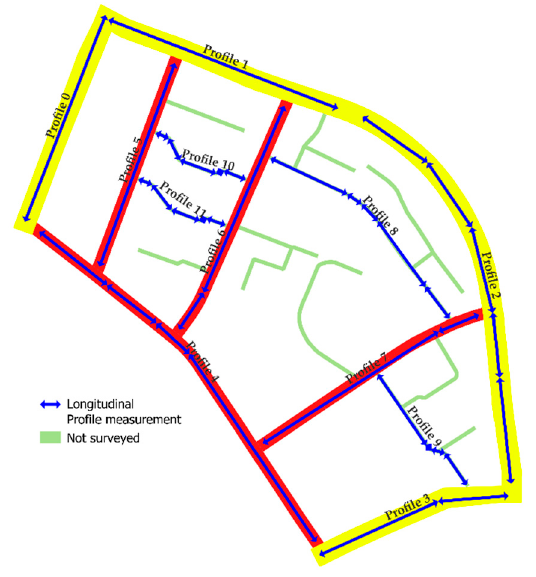
Figure 6. Visualization of IRI results in GIS.